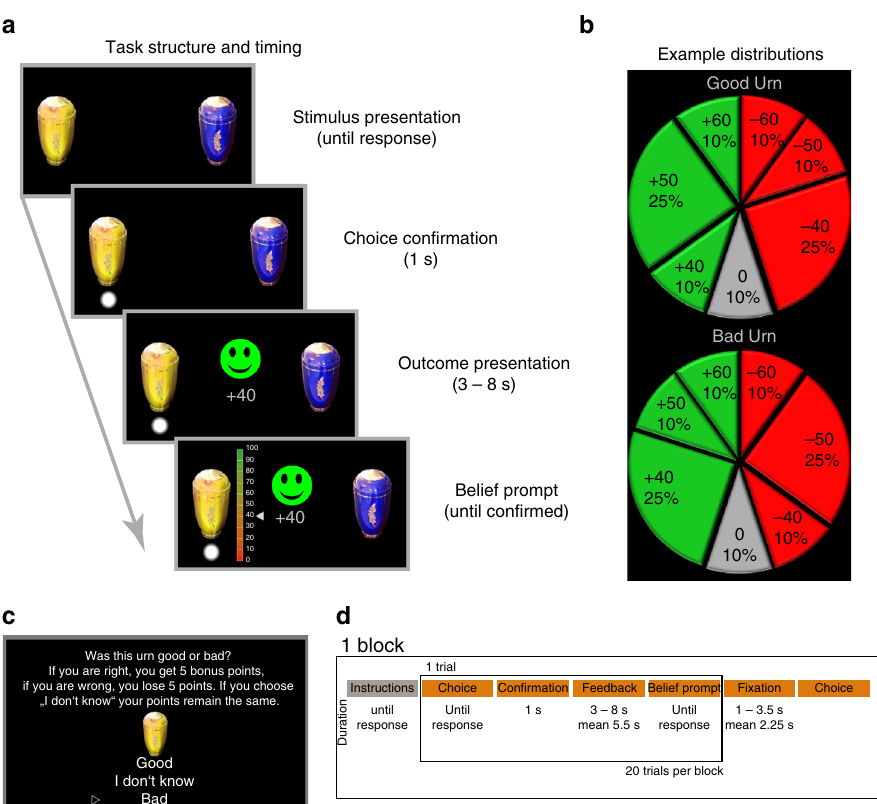
Fig. 1 Task design. Schematic of an example trial and event timing of the task a . All participants were informed b about the exact probability of each possible event in two lotteries (represented by urns yellow and blue) in relation to their long-term valence by presentation of two pie charts. Good urns had a long-term expected value above and bad urns below zero. In this example a , a participant obtained a positive pay-out of 40 points, equivalent